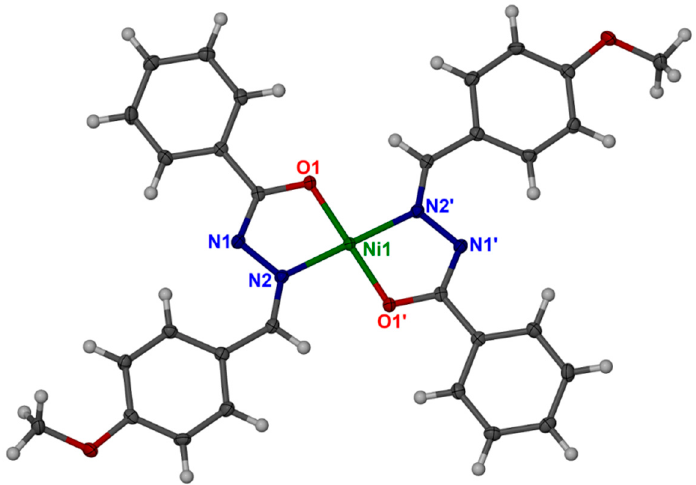
Figure 8. Coordination mode of Ni(II) ion in the Ni(II)-2L with 50% probability thermal ellipsoid (O1 ′ , N1 ′ and N2 ′ are symmetry generated atoms; the symmetry transformation implied for each additional symmetry label atoms: 1-x, -y, 1-z).